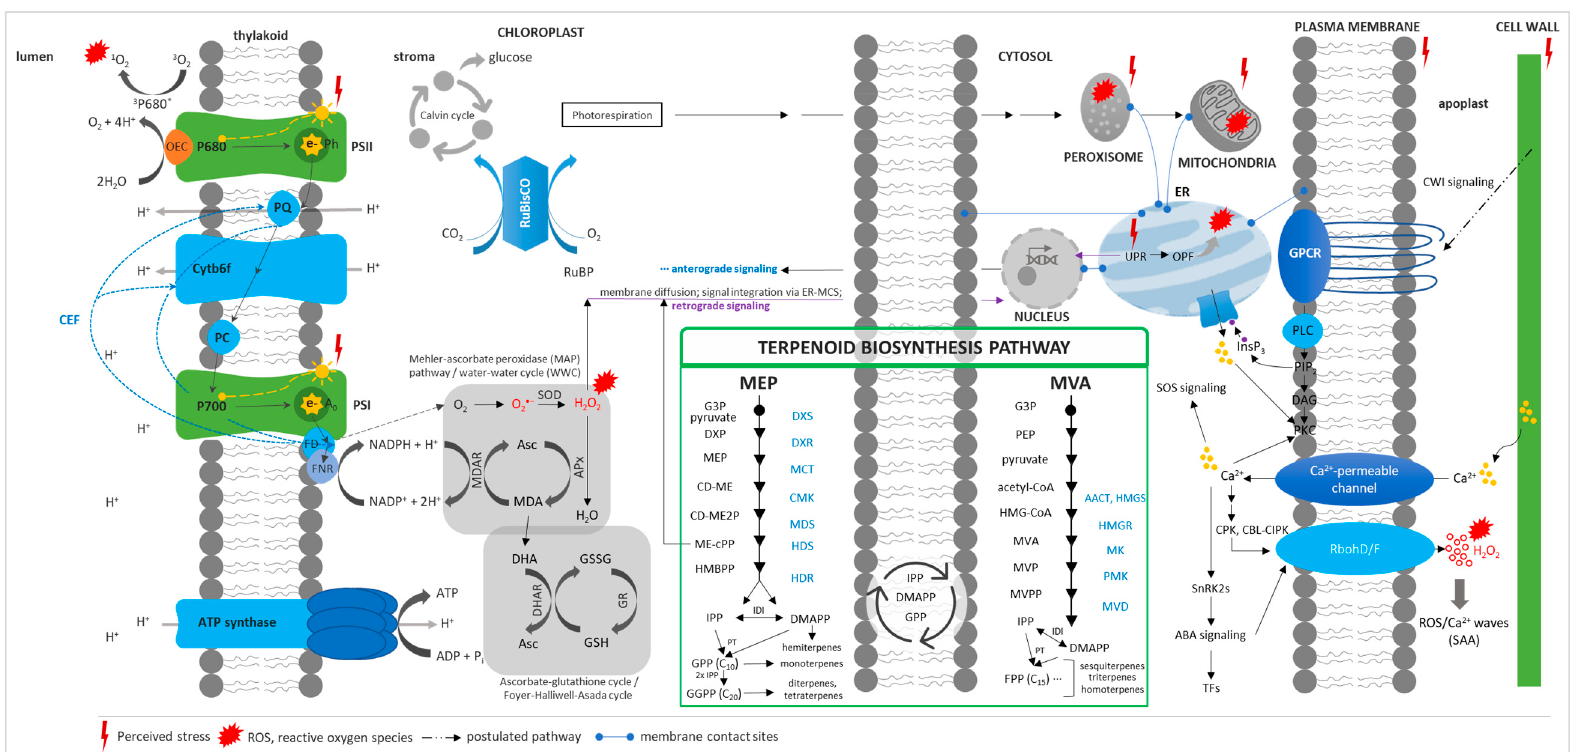
Figure 1 . Plant abiotic stress perception and response, concerning different cell compartments/organelles, and the terpenoid biosynthesis pathway. Stress perception is sensed anywhere in the cell where there is a perturbation of biomolecules and metabolic reactions in various cellular compartments/organelles. Ca 2+ signaling is initiated through [Ca 2+ ] cyt changes due to the influx of Ca 2+ or its release from intracellular calcium stores. Changes in [Ca 2+ ] cyt are sensed by various calcium-binding proteins (e.g., calmodulin, CBL), and signals are relayed to the nucleus through the SOS pathway. Ca 2+ also activates other pathways such as ABA signaling. Reactive oxygen species (ROS) production in the apoplast is initiated in response to Ca 2+ and ABA signaling, and, together, Ca 2+ /ROS signals are automatically propagated to initiate an SAA or distal response. Mechano-sensitive channels through the CWI pathway may also play a role in sensing cellular stress and initiating a signal transduction cascade. ROS during stress is generated at various hotspots, particularly in metabolically active organelles, i.e., chloroplast, mitochondria, peroxisomes, and the endoplasmic reticulum. When ROS production exceeds the quenching capacity of the cell or cellular organelles, retrograde signaling is initiated either through ROS or through ROS-activated/dependent signaling pathways. ROS signals from different organelles may be integrated and fine-tuned through the ER–MCS. To prevent photoinhibition in the chloroplast, particularly that of PSII, CEF, Mehler peroxidase reaction, and photorespiration may relieve the system of the excess of reducing equivalents, while antioxidant defense systems such as the ascorbate–glutathione cycle may alleviate oxidative stress by quenching ROS. PSI/II,